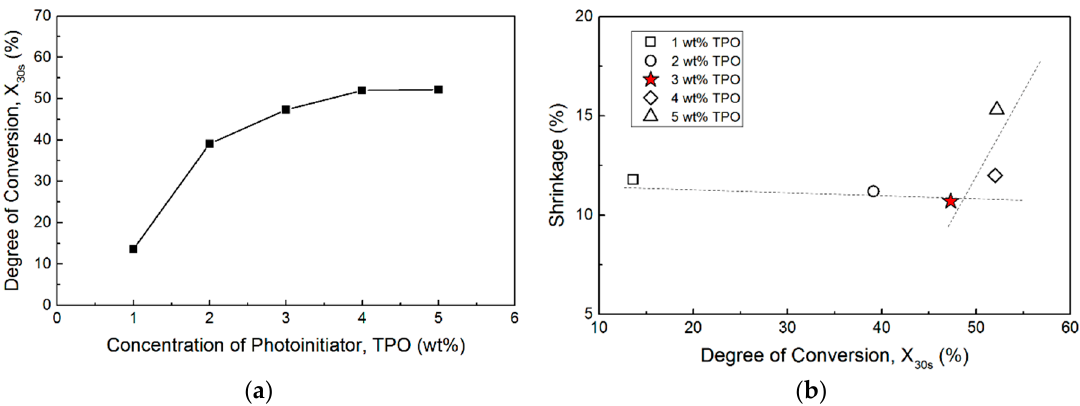
Figure 2. ( a ) The effect of TPO concentration on the degree of conversion, X 30s ; ( b ) a plot of rapid volume shrinkage vs. X 30s . volume shrinkage vs. X 30s